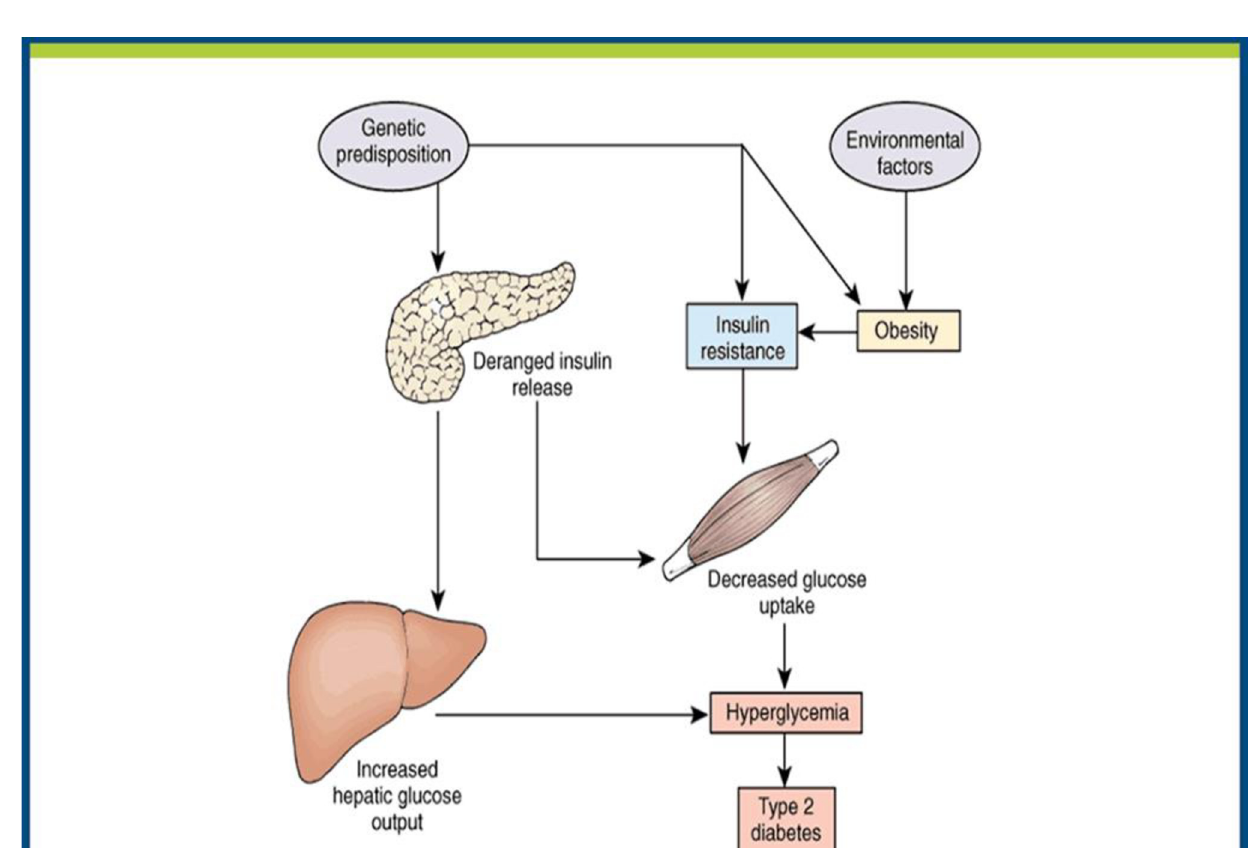
Fig 1. Pathogenesis of type 2 diabetes mellitus